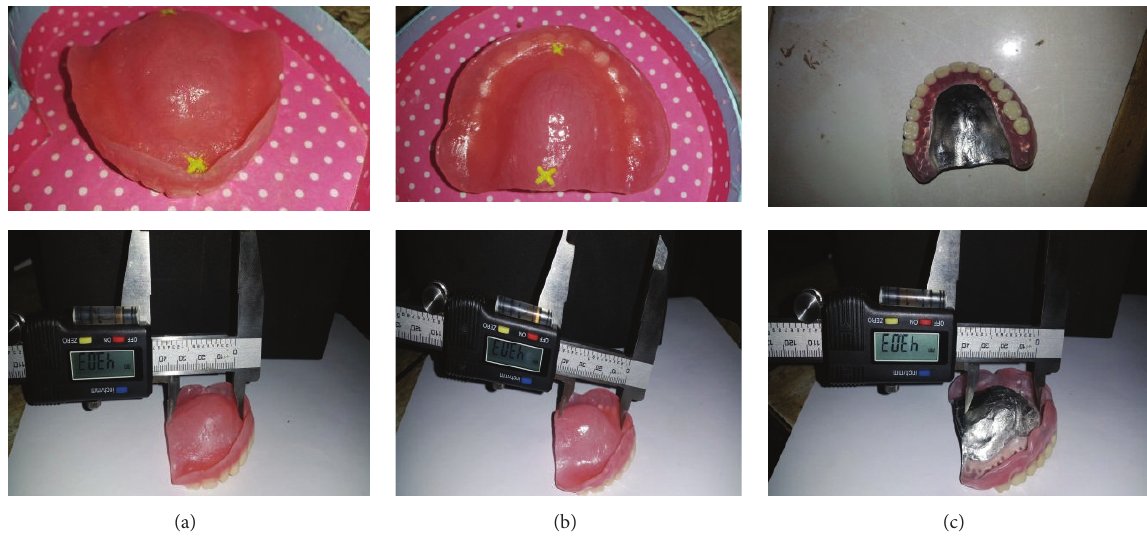
Figure 1: The picture demonstrated points A and B on the fitting surface of